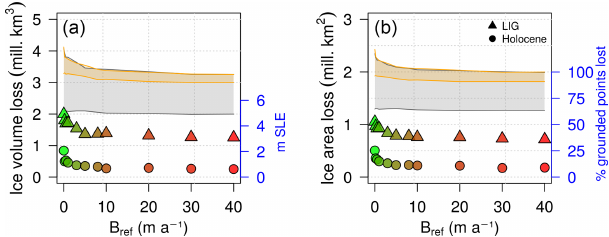
Figure 4. Distribution of the ice volume (a) and area (b) lost dur- ing the LIG (triangles) and the Holocene (circles) as a function of B ref . Grey and yellow shades show the range between the maximum glacial and the minimum interglacial ice volumes (area) for LIG and Holocene, respectively. The loss is calculated between the time at which the ice volume reaches its maximum value simulated before the deglaciation (between 132 and 128kaBP for TII and between 13 and 9kaBP for TI) and its following ice minimum (between 122 and 121kaBP for the Eemian and between 8 and 0kaBP for the Holocene). The colours of the points follow the legend of Fig. 2 for clarity. Each ice volume loss has been converted to value of sea-level-equivalent anomaly (ms.l.e. with respect to its simulated present-day volume.